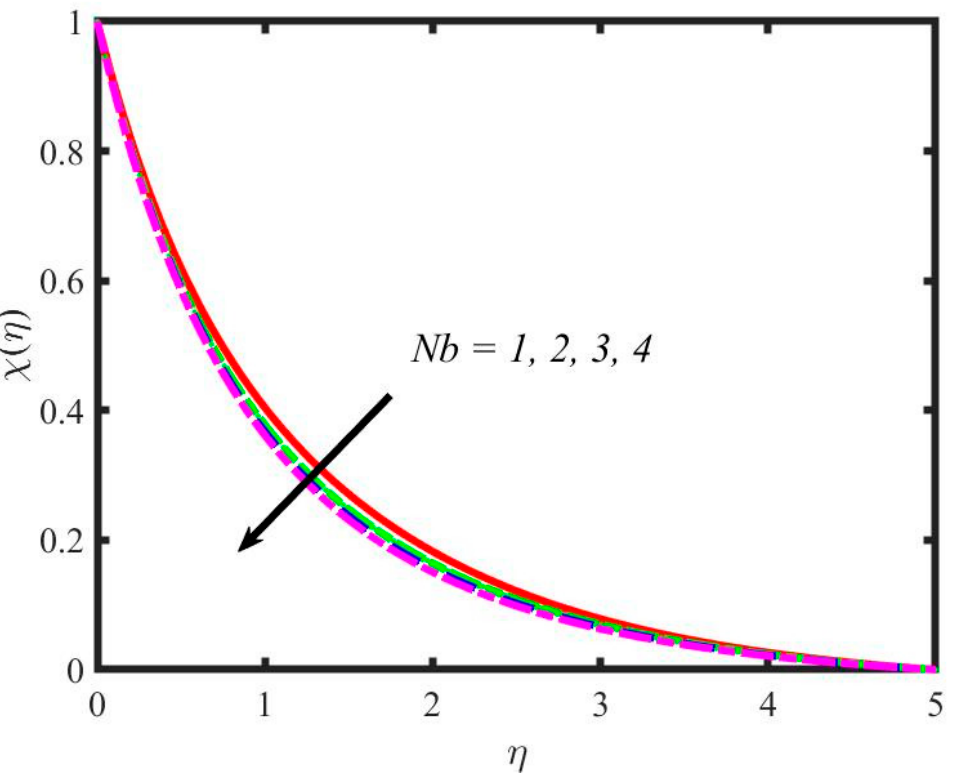
Figure 23. Variations in microorganism profile for Brownian motion parameter.